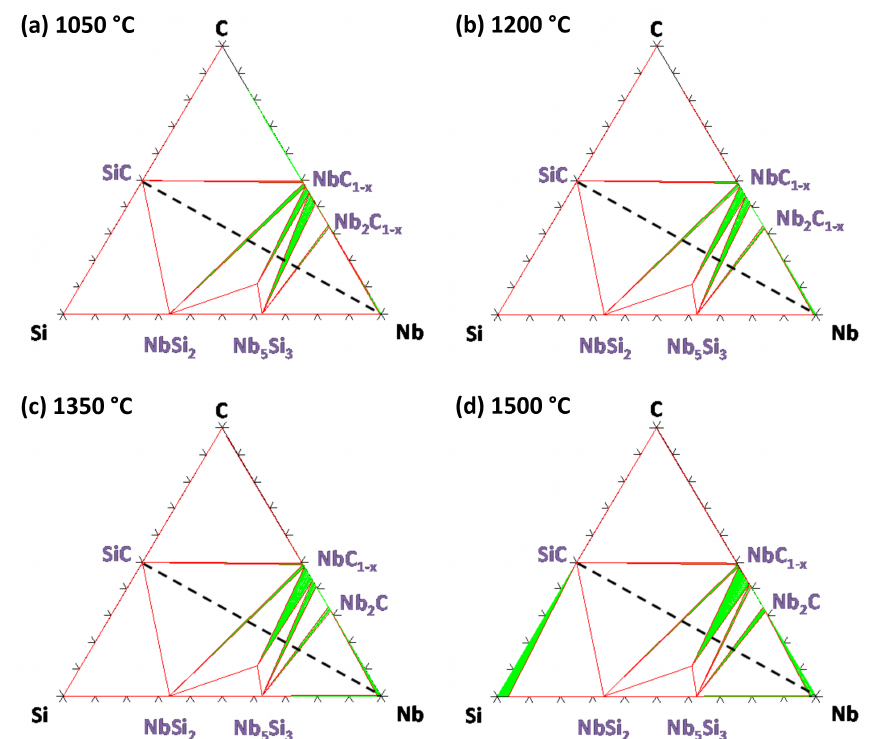
Figure 6. Isothermal sections of the ternary Nb–Si–C system calculated with Thermo-Calc software and the FUELBASE database at ( a ) 1050 ◦ C, ( b ) 1200 ◦ C, ( c ) 1350 ◦ C and ( d ) 1500 ◦ C.